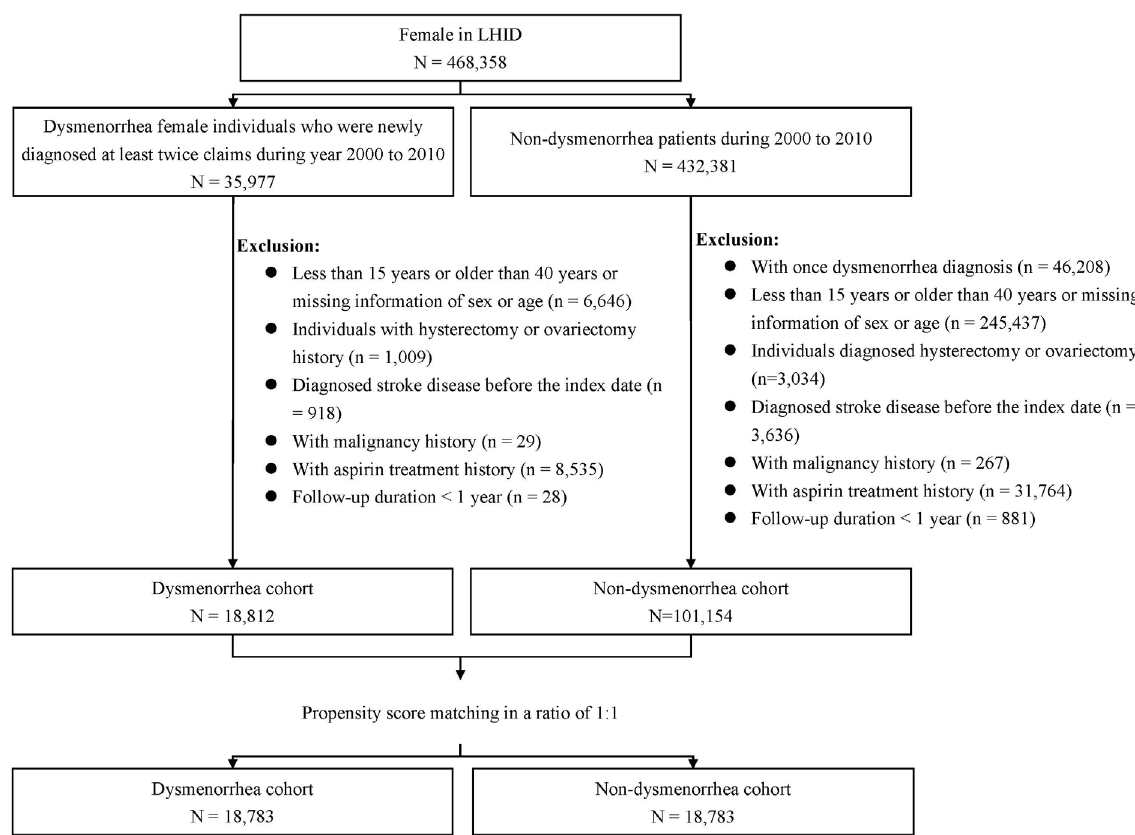
Figure 1. Flow chart for establishing study cohorts.